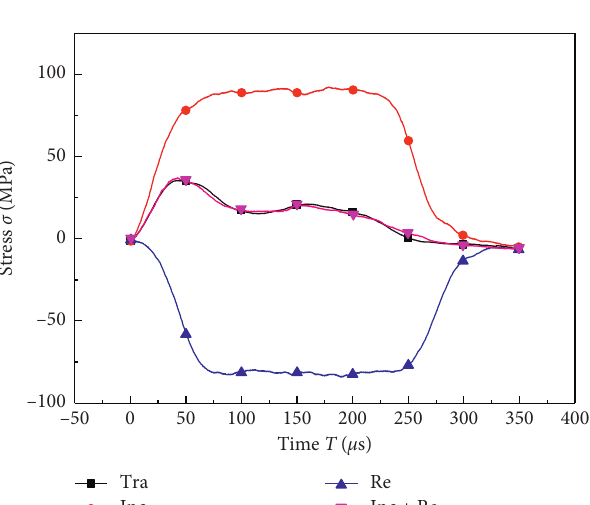
Figure 3: Typical